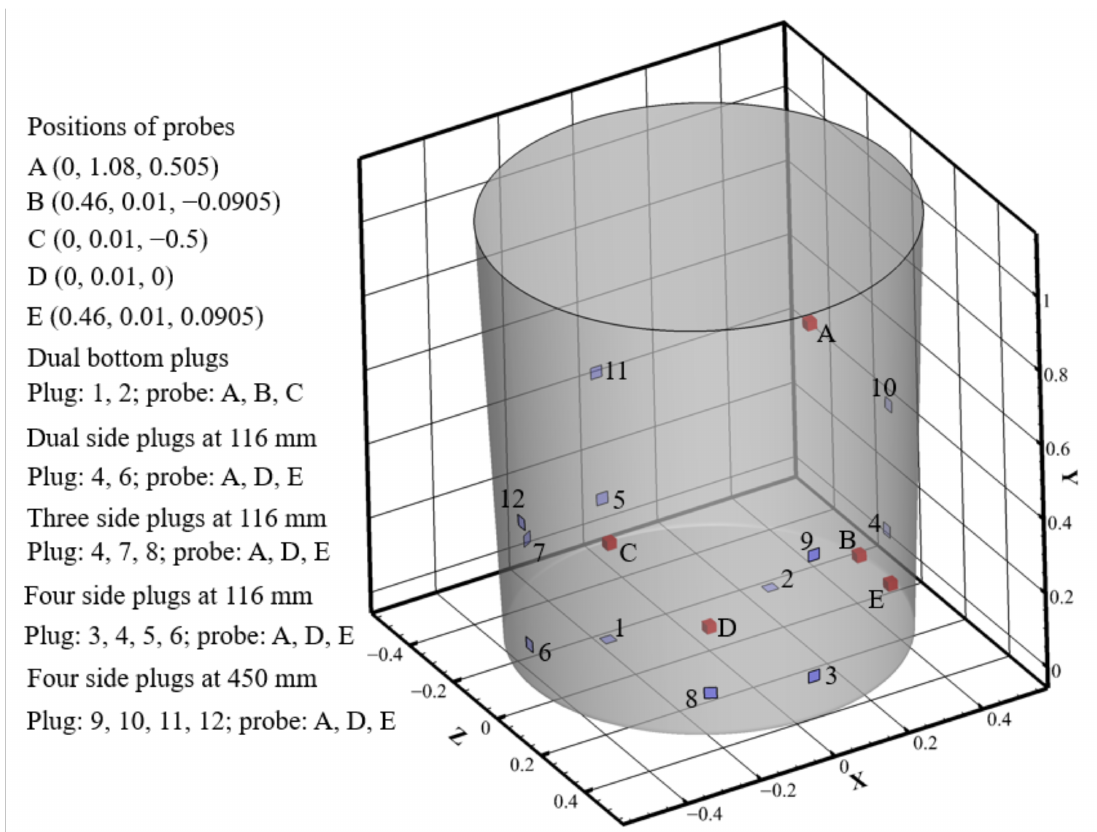
Figure 2. Three-dimensional coordinate system of the model ladle. First, the gas (nitrogen) was injected through the plugs until a quasi-steady-state flow pattern was reached, the tracer (500 mL saturated KCl solution or 50 mL color dye) was injected into water through a funnel at the center of the water surface. The output signals of electrical conductivity probes were recorded for every 0.1 s by a personal computer combined with a data acquisition system. The mixing phenomenon of color dye was recorded by a video camera (Sony, Shanghai, China). The mixing time was determined as the tracer concentration from modified conductivity curves, which was continuously within ± 5% of a well-mixed bulk value [13]. Three measurements were made for each operating condition, and an average mixing time was thereby determined. Figure 3a shows one conductivity curve, which was measured by a probe during gas blowing. C 0 is the conductivity of water. C e is the conductivity of water and the tracer. In order to eliminate the interference of water conductivity, the modified conductivity curves, i.e., conductivities of dual bottom plugs under the flow rate of 1.2 m 3 /h minus the water conductivity are shown in Figure 3b. Figure 3b shows that the conductivity curves of the probe at different positions are different. The sequence of the tracer achievement is position A, position B, and position C in the ladle with dual bottom plugs. The measured mixing times of position B and C are longer than that of position C. This condition was influenced by the fluid flow path and the stagnant region and will be discussed in Section